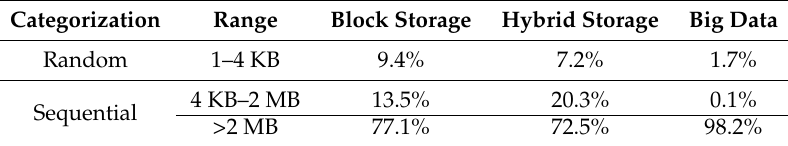
Table 1. Distribution of I/O patterns under three